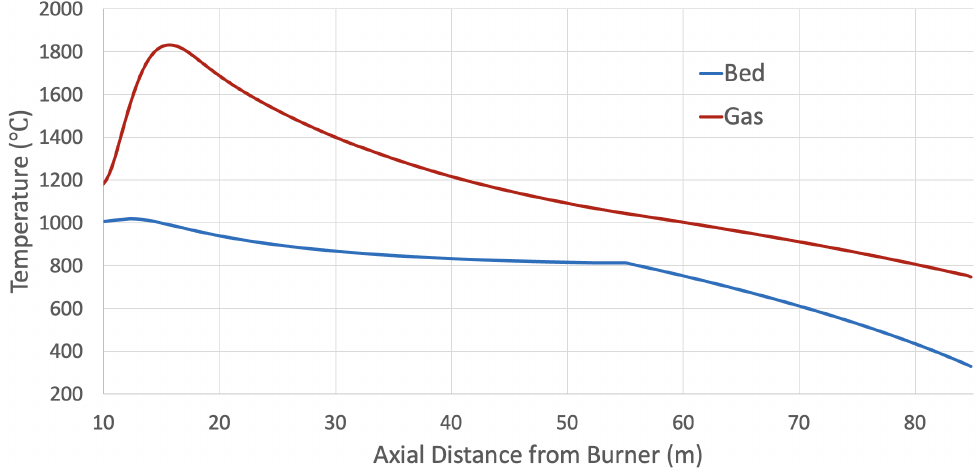
Figure 4. Simulated bed and average axial gas temperature for a dry